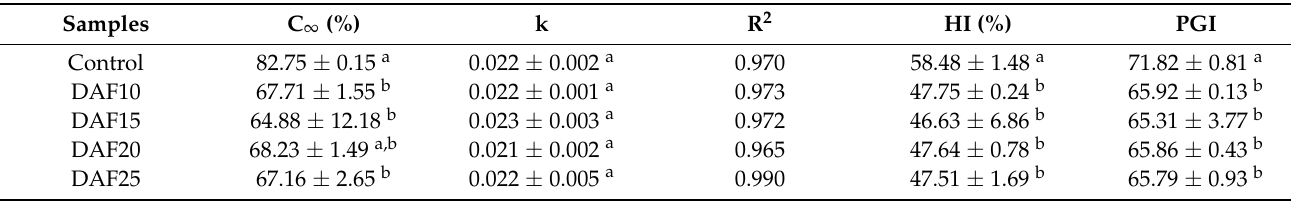
Table 6. Equilibrium Concentration (C ∞ ), Kinetic constant (K), Hydrolysis Index (HI), and Predicted Glycemic Index (PGI) for acorn noodles with different substitution levels a,b .